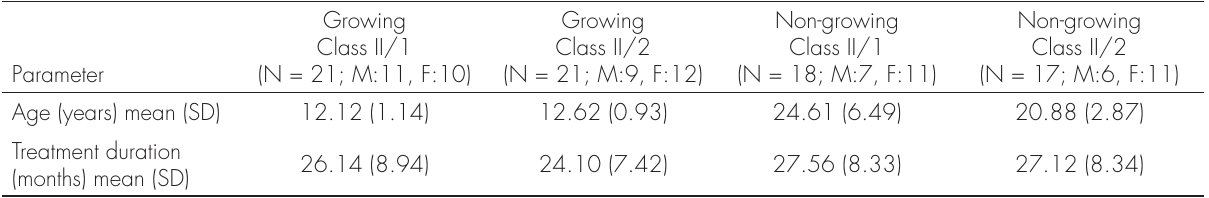
Table I. Distribution of patients according to diagnosis, gender and age, and the mean and standard deviation for age and treatment duration of all sample groups.